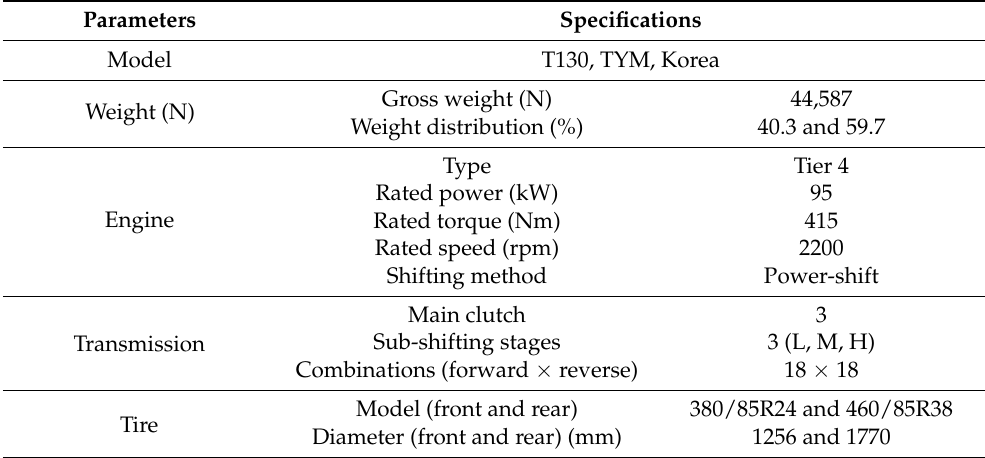
Table 1. The specifications of the partial power-shift transmission (PST) tractor used in this study. Parameters